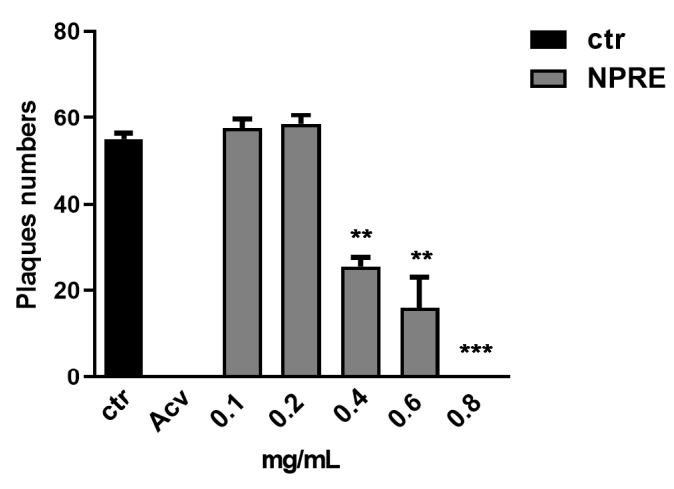
Figure 2. Effects of NPRE on herpes simplex 1 (HSV-1) replication by plaque reduction assay. Vero cells were infected with HSV-1 (50 plaque forming units (PFU) / 100 µ L) for 1 h and then treated with NPRE (0.1, 0.2, 0.4, 0.6, 0.8 mg / mL). The DMSO was used in the control samples and acyclovir (20 µ M) was used as positive control. Data are expressed as a mean ( ± SD) of at least three experiments, and asterisks (**, and ***) indicate the significance of p -values less than 0.01 and 0.001, respectively. Plants 2020 , 9 , x FOR PEER REVIEW